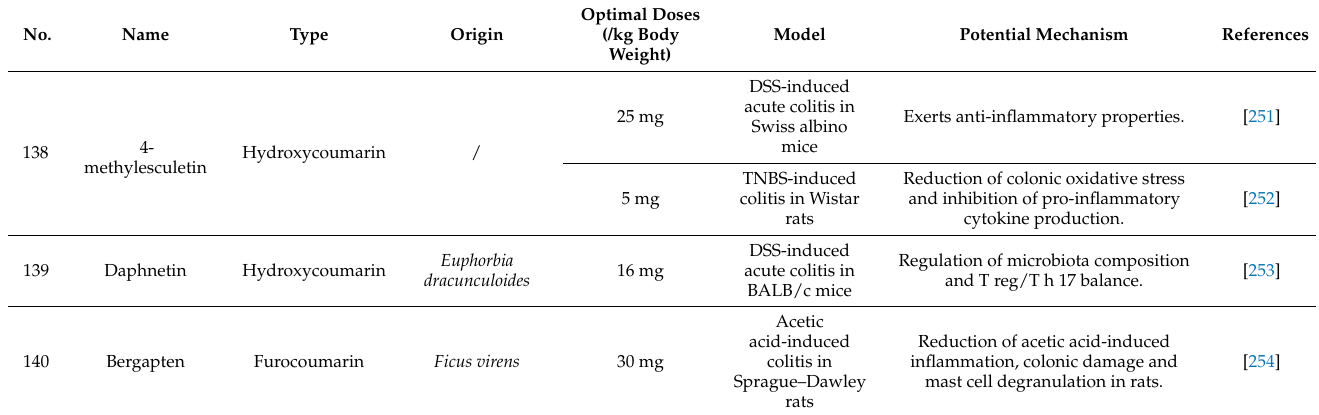
Table 7. In vivo therapeutic effects of coumarins on experimental